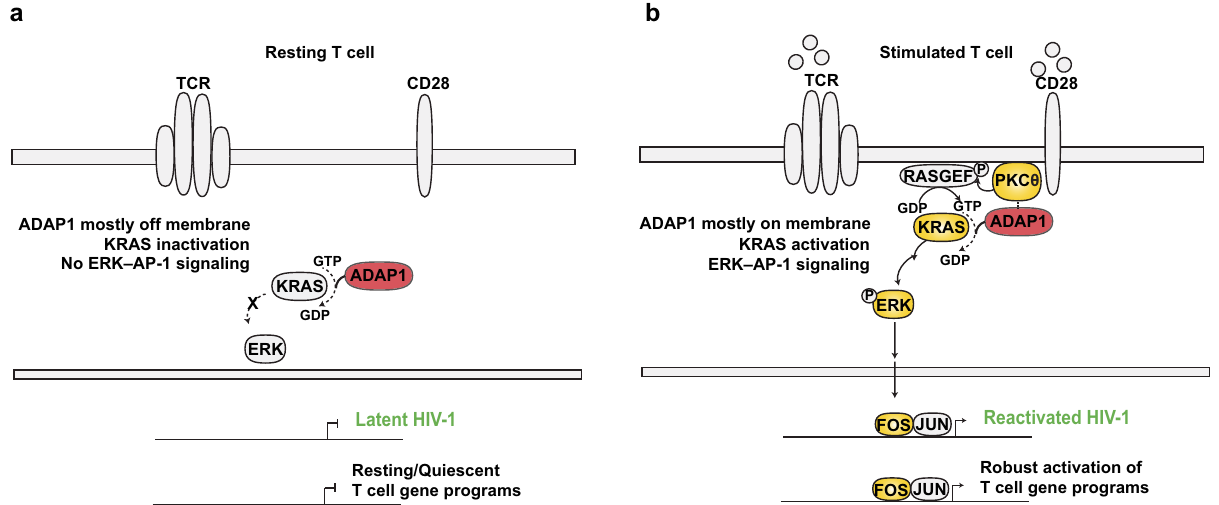
Fig. 8 Proposed simpli fi ed model of ADAP1-mediated T cell signaling stimulation leading to latent HIV-1 reactivation. a In resting conditions, ADAP1 is largely localized to the cytosol, HIV-1 is in a latent state and T cell programs are quiescent. b Upon stimulation (TCR/CD28), ADAP1 is re-localized to the cell membrane where it interacts with immune signalosome proteins including PKC θ and signal transducer protein KRAS, stimulating the MAPK pathway including KRAS – ERK – AP-1 (Fos/Jun). Activated AP-1 binds cis -elements on the HIV-1 genome inducing reactivation from latency. For T cell genes, ADAP1- induced AP-1 bind cis -elements of genes required for T cell programs, including genes that require NFAT:AP-1